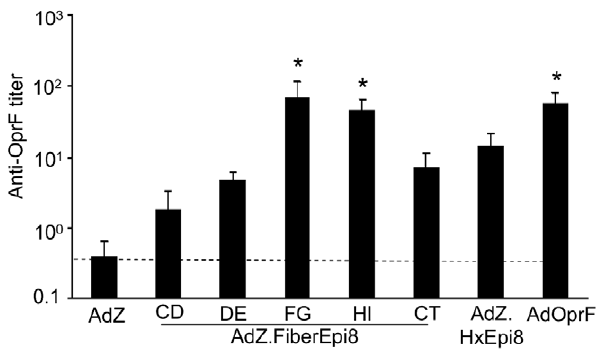
Figure 6. Immunization with Epi8 fiber-modified Ad vectors induces anti- P. aeruginosa lung mucosal humoral immunity. BALB/c mice were immunized via the intramuscular route with the fiber-modified Ad vectors AdZ.F(CD)Epi8, AdZ.F(DE)Epi8, AdZ.F(FG)Epi8, AdZ.F(HI)Epi8 and AdZ.F(CT)Epi8, the hexon-modified AdZ.HxEpi8, AdOprF or AdZ (all 10 10 pu/mouse) and boosted with the same vectors at 2 and 5 wk. Anti-OprF IgG in bronchioalveolar lavage fluid was analyzed by ELISA after 8 wk. Data are shown as the mean 6 SEM of 5 mice/group. Limit of detection is indicated by the dashed line. * denotes p , 0.05, AdZ.F(FG)Epi8, AdZ.F(HI)Epi8 or AdOprF compared to all others.